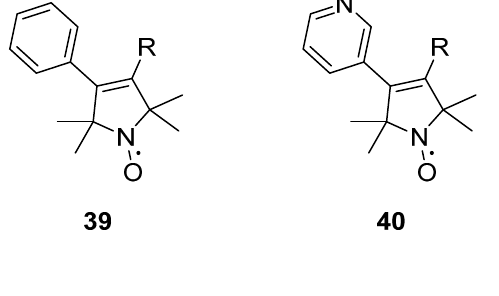
Figure 6. Structures of pyrrolines with rigid substituents on the 4